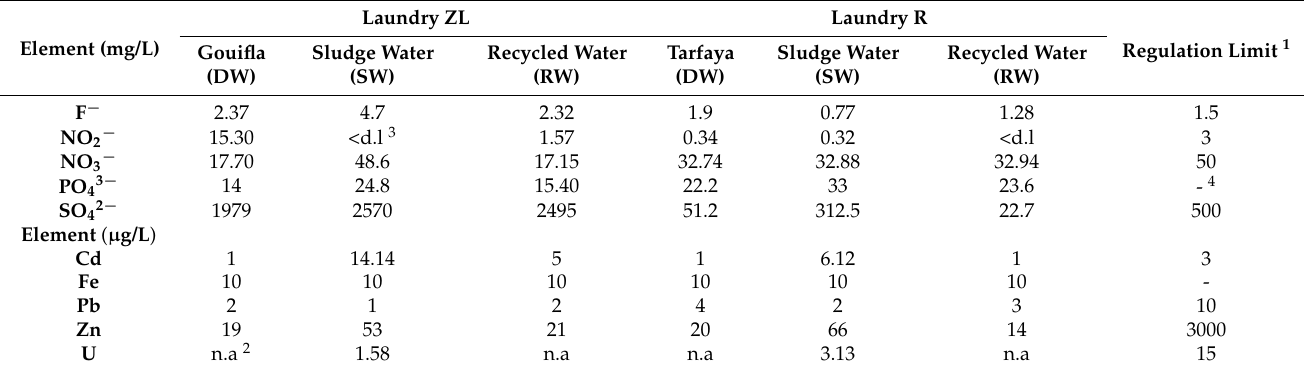
Table 4. Results of chemical analysis of drilling water (DW), sludge water (SW), and recycled water (RW) from M’Dhilla- Zone L (ZL) and Redeyef (R)